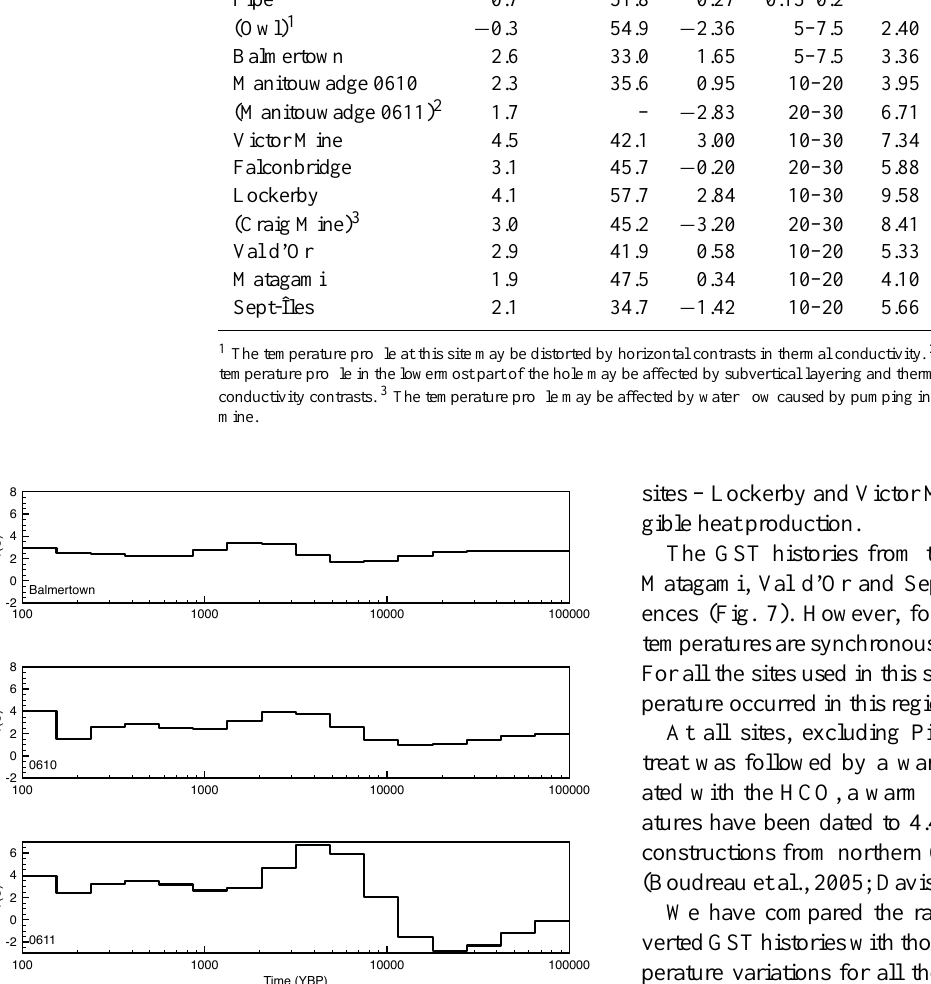
Figure 5. Ground surface temperature history for the western On- tario boreholes: Balmertown and Manitouwadge 0610 and 0611. The temperatures have been shifted with respect to the reference surface temperature of the site, T o , as shown in Table